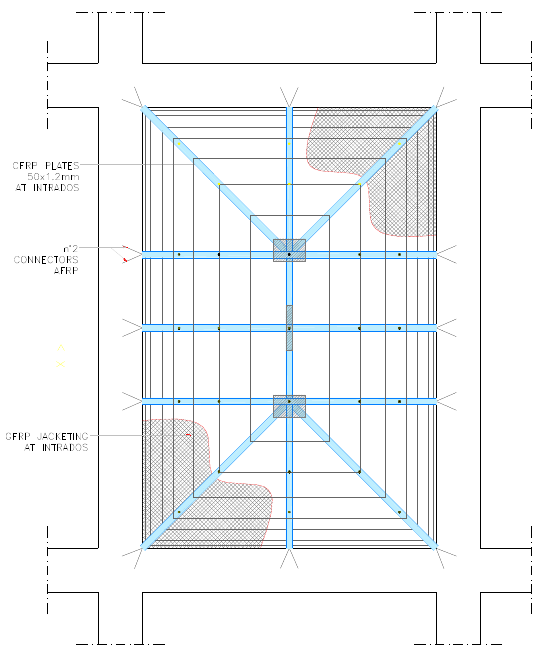
Figure 4. Layout of reinforcement for the L’Aquila vault.